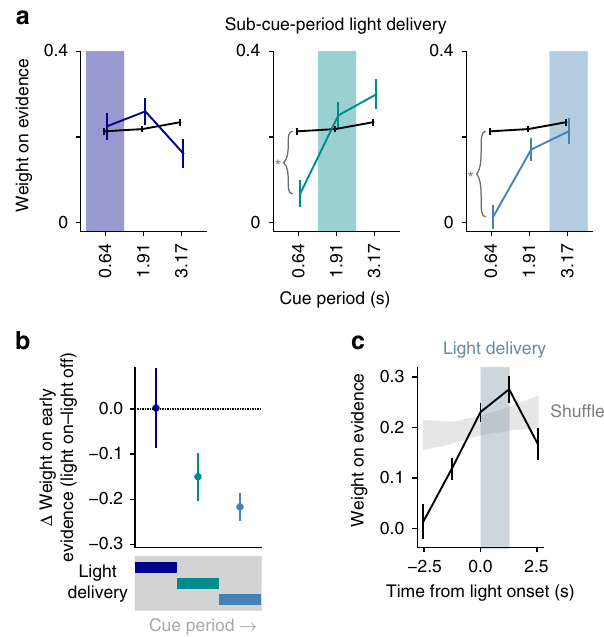
Fig. 2 Cerebellar disruption in fl uences weighting of past evidence. a Regression of animal choices on evidence quantity for light-off (black) and light-on (colored) trials ( n = 32,311 light-off trials, 5669 light-on trials, 285 sessions, 8 mice). Weights indicate the extent to which evidence was used to guide decisions, and the sum of weights is proportional to overall performance. Colored shading indicates the time of light delivery. Error bars: s.e.m. of regression weights. * p < 0.01 (99% CI on fi rst bin, light-off: 0.19 – 0.23; light-on middle third: − 0.01 – 0.15; light-on last third: − 0.06 – 0.09). b Change in weight on evidence in the fi rst third of cue period as a function of when light was delivered during the cue period. Data points and error bars show mean ± s.e.m. across mice. c Evidence weight as a function of time relative to the onset of light delivery, with all cue-period light delivery conditions included (see Methods). Shuf fl e: light delivery time labels were shuf fl ed before regression. Error bars: bootstrap